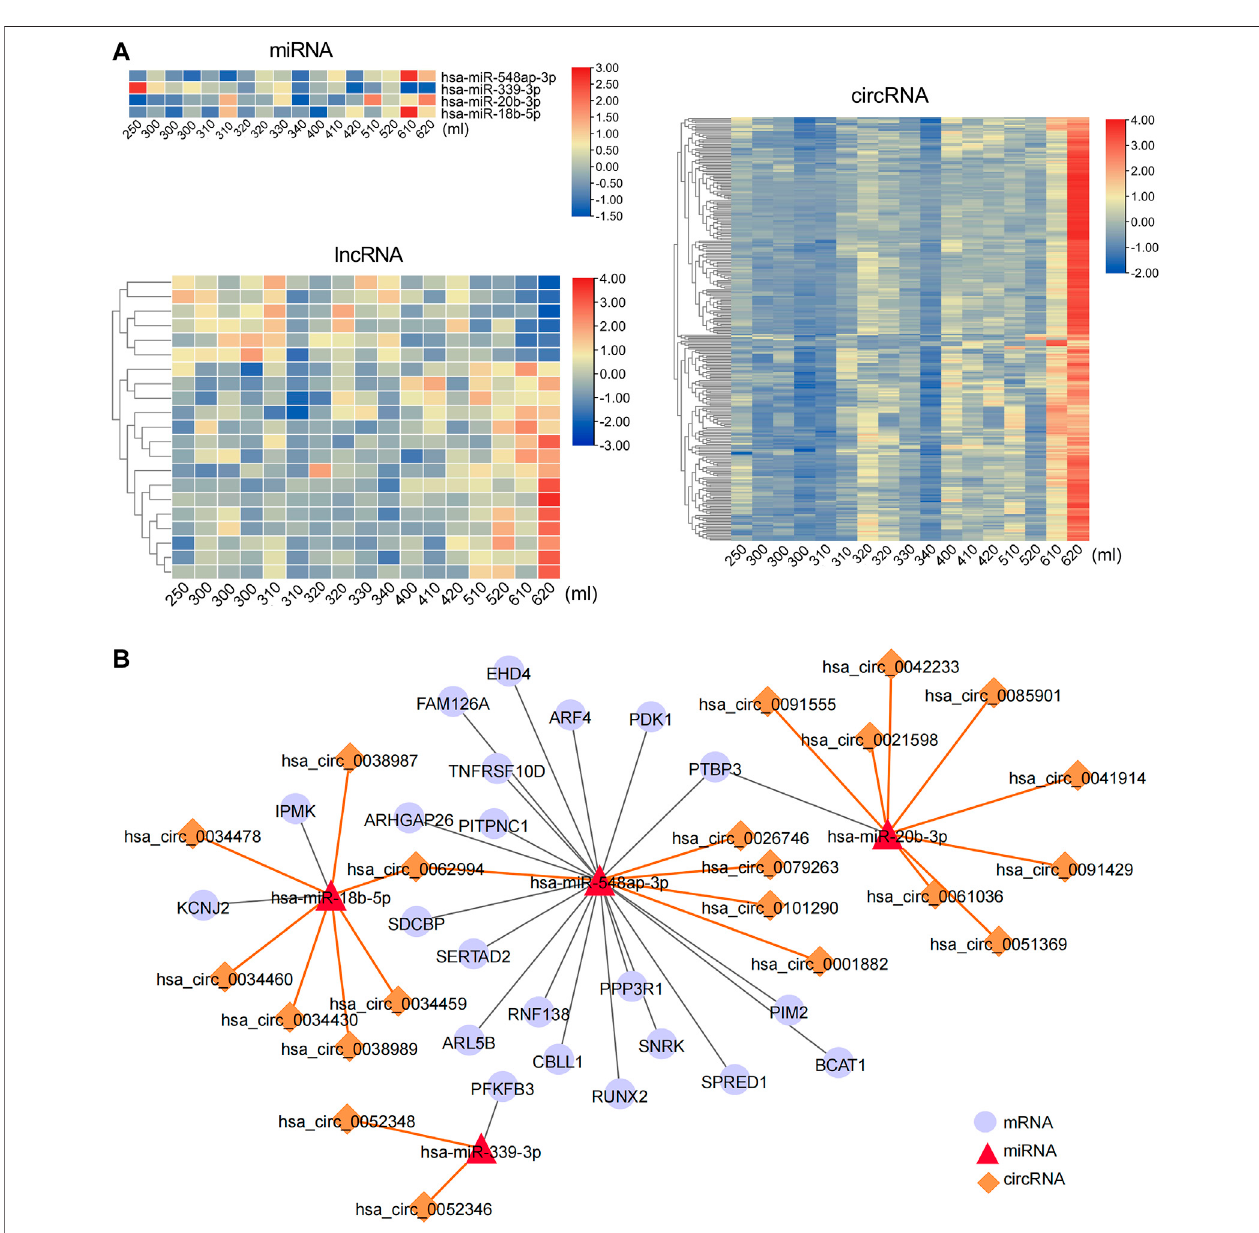
FIGURE 6 | Postpartum bleeding-correlated circRNA/lncRNA – miRNA – mRNA ceRNA network. (A) Heat map of expression of Postpartum bleeding-correlated miRNAs, lncRNAs, and circRNAs. Data associated with this fi gure can be found in Supplementary Table S12 . (B) Postpartum bleeding – correlated ceRNA